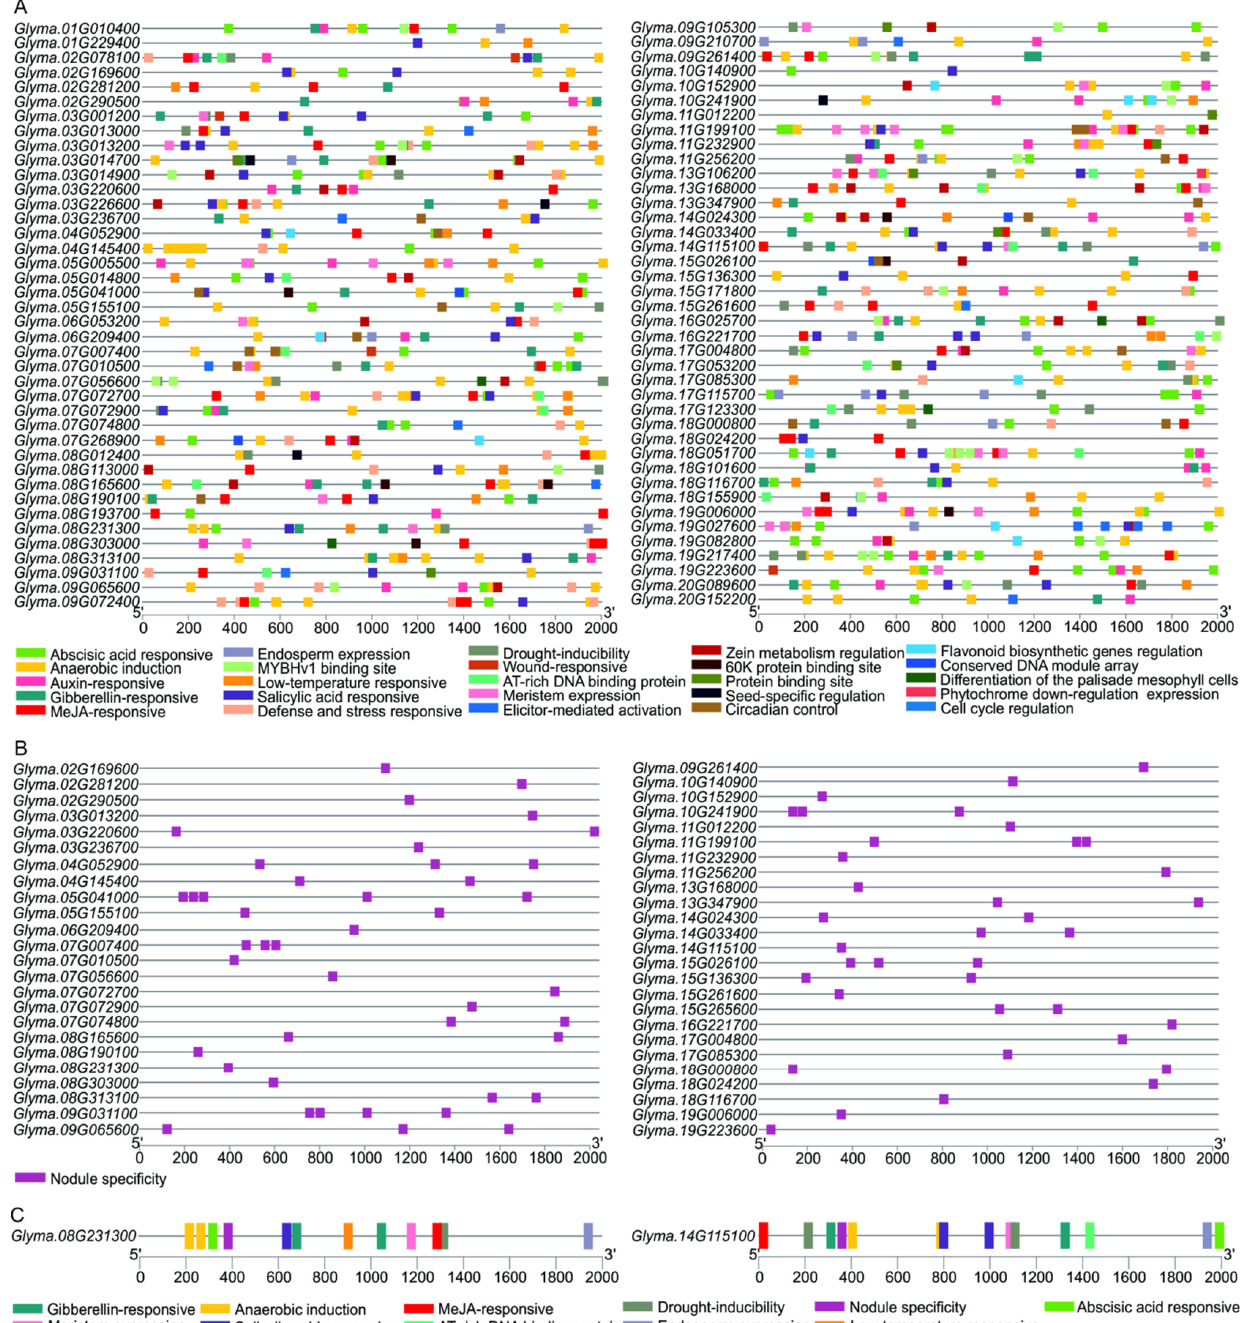
Figure 4. Predicted cis elements in the promoter regions of DDX genes. ( A ) Predicted cis elements of all DDX genes. ( B ) Predicted nodule-specific cis elements of 49 DDX genes. ( C ) Predicted cis elements of two soybean specific DDX genes. The scale bars at the bottom indicate the lengths of the promoter sequences. Color boxes indicate cis elements in the promoter regions.